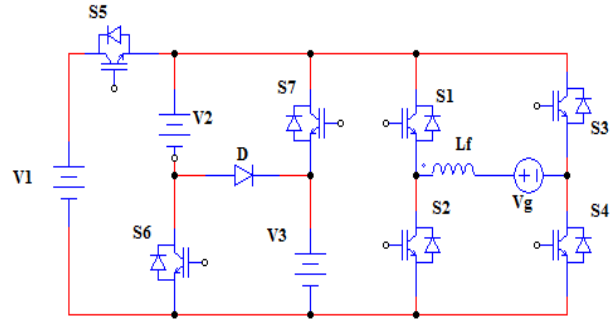
Figure 2. Seven-switch, seven-level topology [51].